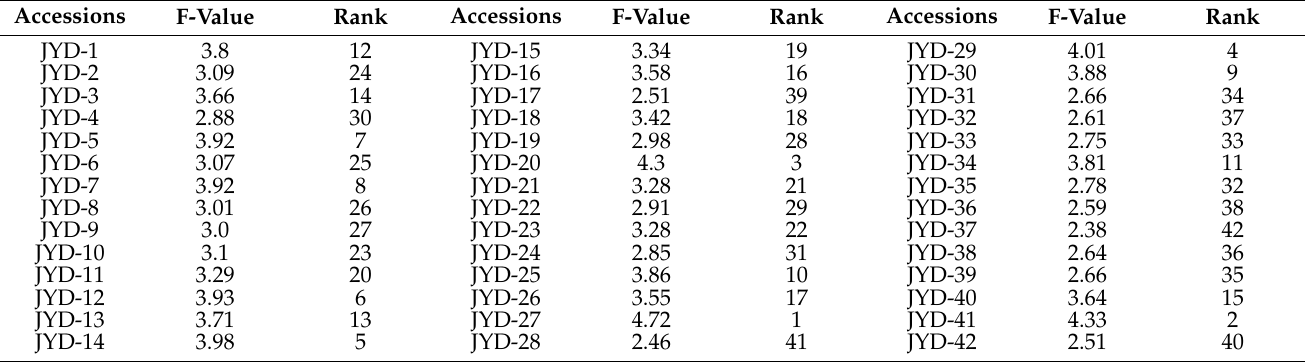
Table 6. Comprehensive assessment of 42 tiger nut accessions based on the 14 agronomic and biochemical